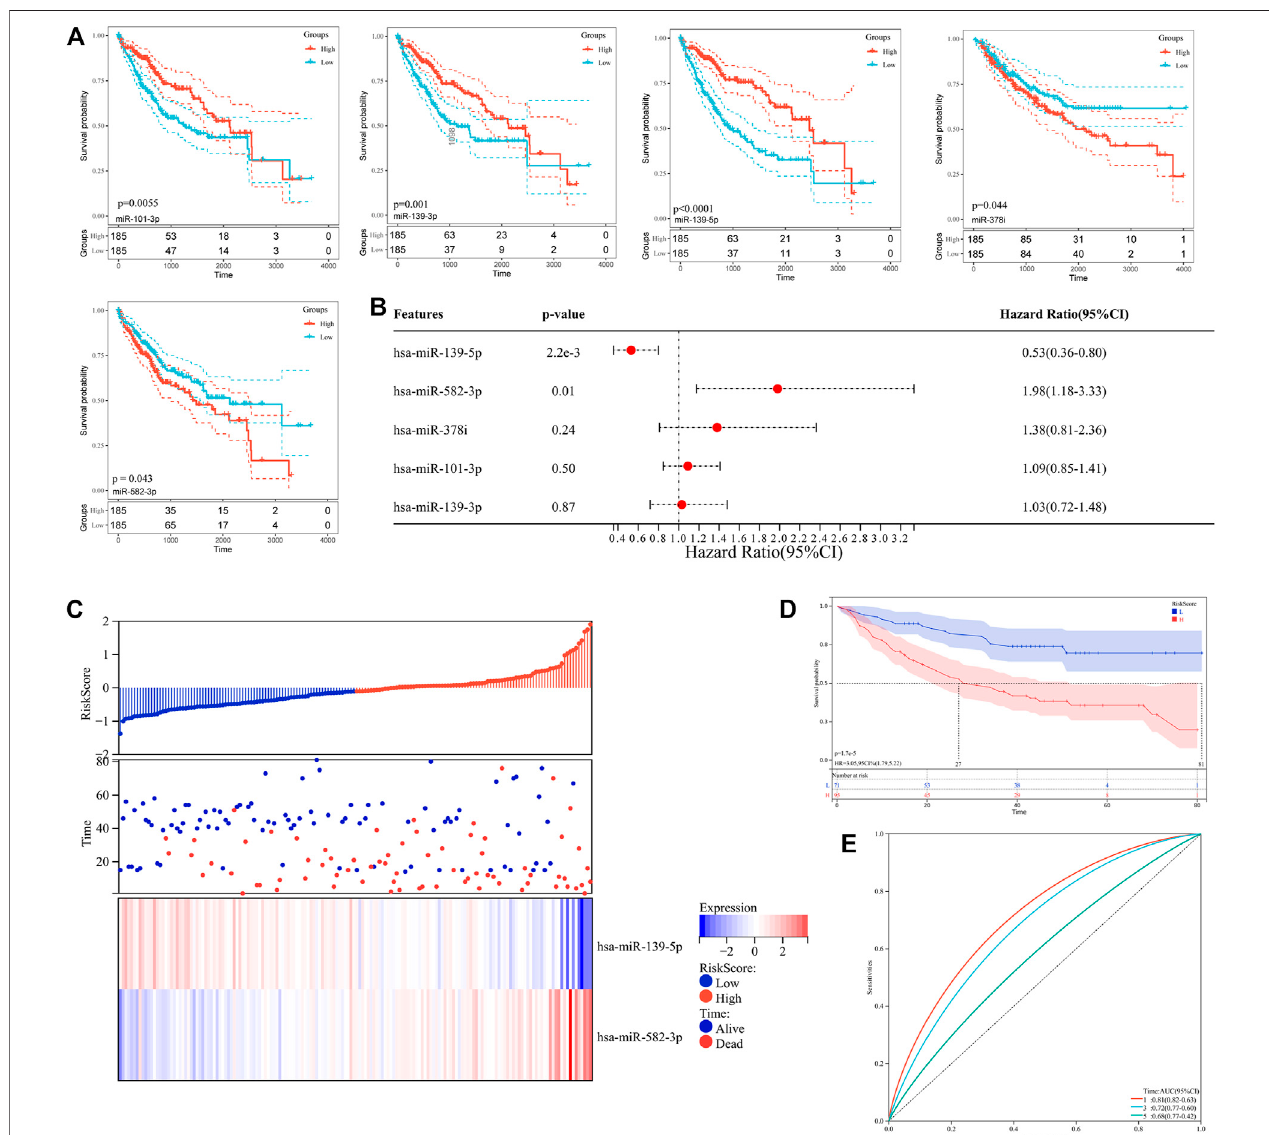
FIGURE 2 | (A) Kaplan – Meier survival curve analysis of fi ve miRNAs (miR-139-5p, miR-139-3p, miR-101-3p, miR-582-3p, miR-378i). (B) Forest plot of Cox multivariateanalysisof fi vemiRNAs (miR-139-5p,miR-139-3p,miR-101-3p,miR-582-3p,miR-378i). (C) Relationship betweentheexpression ofmiR-139-5p and miR- 582-3p and patient survival in the risk assessment model. (D) Kaplan – Meier survival curve analysis in the risk assessment model. (E) ROC curve analysis in the risk assessment model.